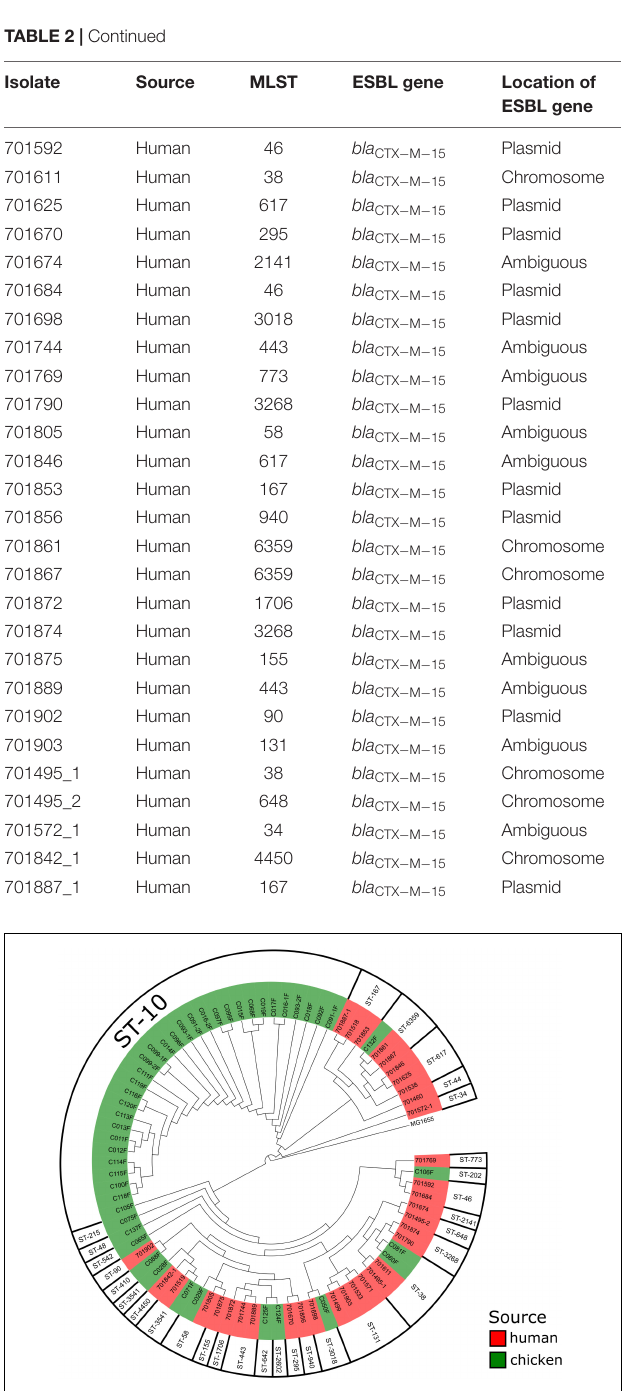
FIGURE 2 | Whole genome-based phylogenetic analysis of the ESBL-producing Escherichia coli using Escherichia coli MG1655 as a reference